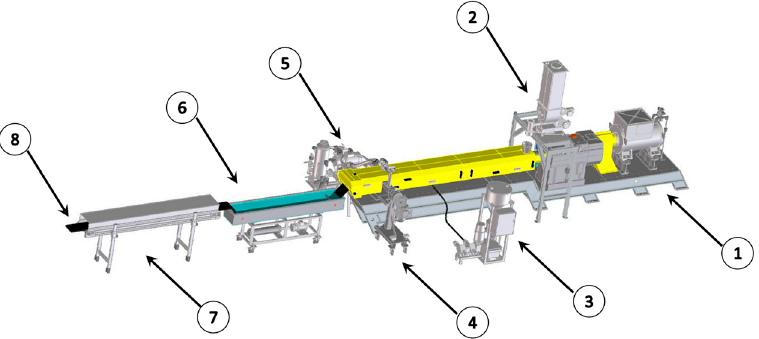
Figure 1. Extrusion layout-Maris EVOREC RUBBER. 1. Extruder, 2. gravimetric feeder, 3. gravimetric pump, 4. side degassing unit, 5. vacuum pump, 6. water bath, 7. cooling and drying belt, 8. devulcanized rubber strip.